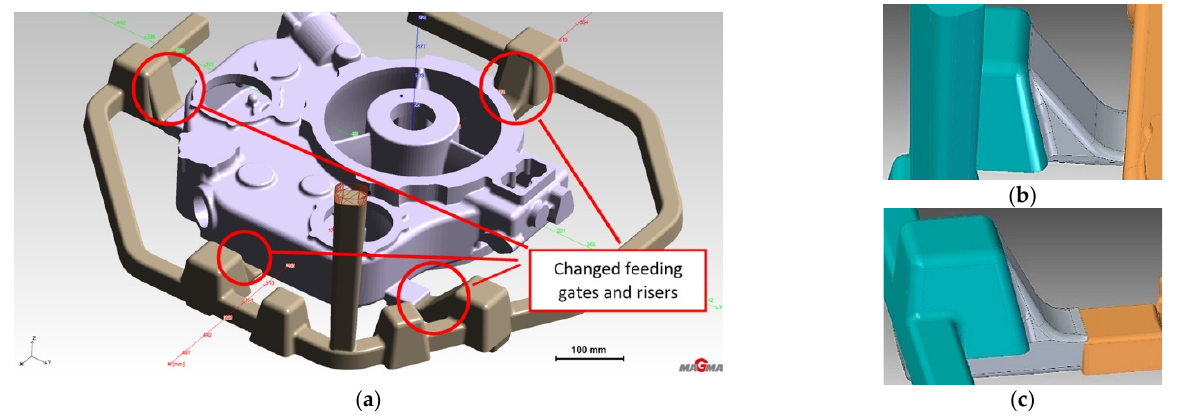
Figure 8. Stage 2 ( a ) Gating system with changed feeding gates and risers; ( b ) changed riser WD2; ( c ) changed riser WD4.